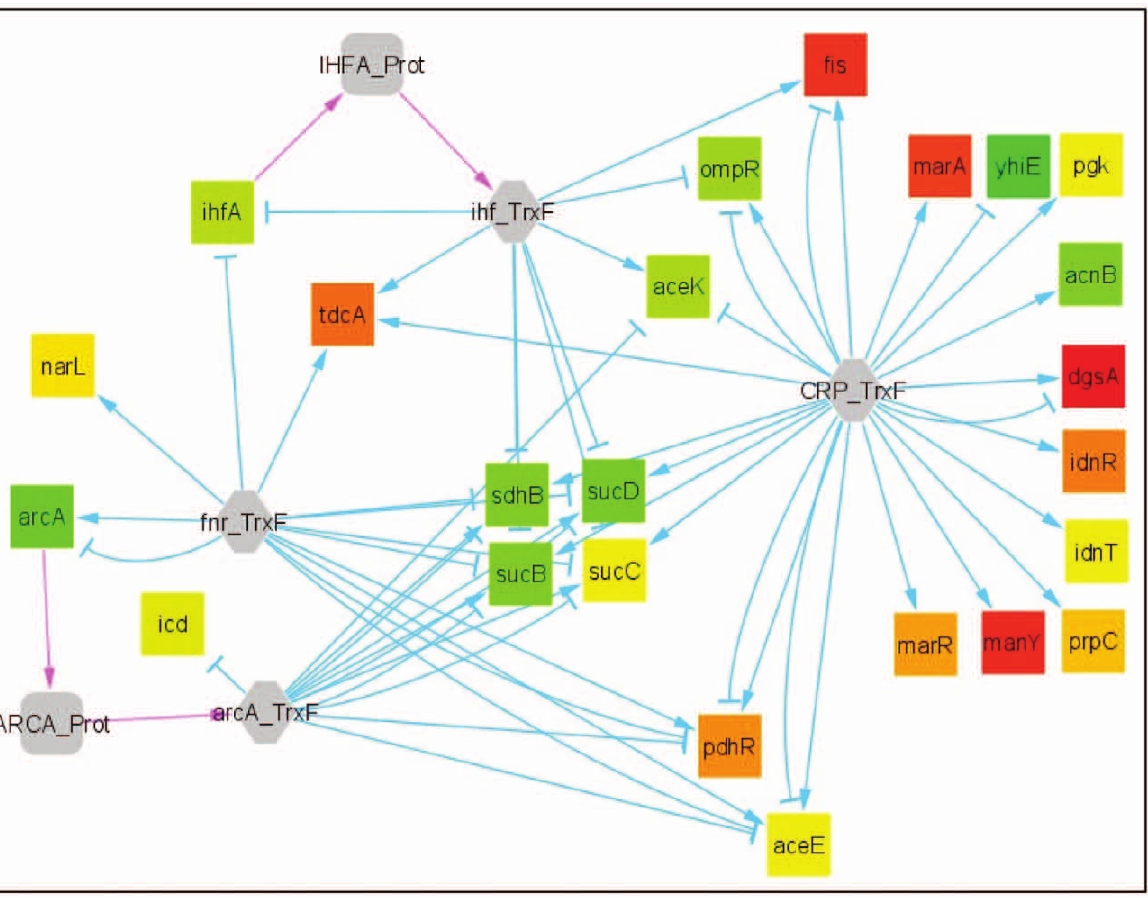
Figure 6. Major transcriptional factors implicated in a D zwf metabolic reshuffling using MODAM. The ‘‘select experiment’’ option of the MODAM interface was used to pick the D zwf data provided by Ishii et al . [9]. Each cursor (gene, protein, reaction and metabolite) were set on 10% of highlighted differential data. The ‘‘extract subnetworks’’ option was then activated to select only the differentially expressed nodes and their first neighbours (as in 5d). From the ‘‘up and down regulated’’ network, nodes were ranked according to their number of connections (degree). Among the nine most connected elements, four are transcription factors. The selection of these transcription factors and their neighbours was reiterated. This iterative process resulted in the presented subnetwork. The drawing was obtained using a force directed algorithm, manually adjusted to group genes that are regulated by the same sets of transcription factors (e.g. the four genes in the centre are regulated by the four transcription factors).